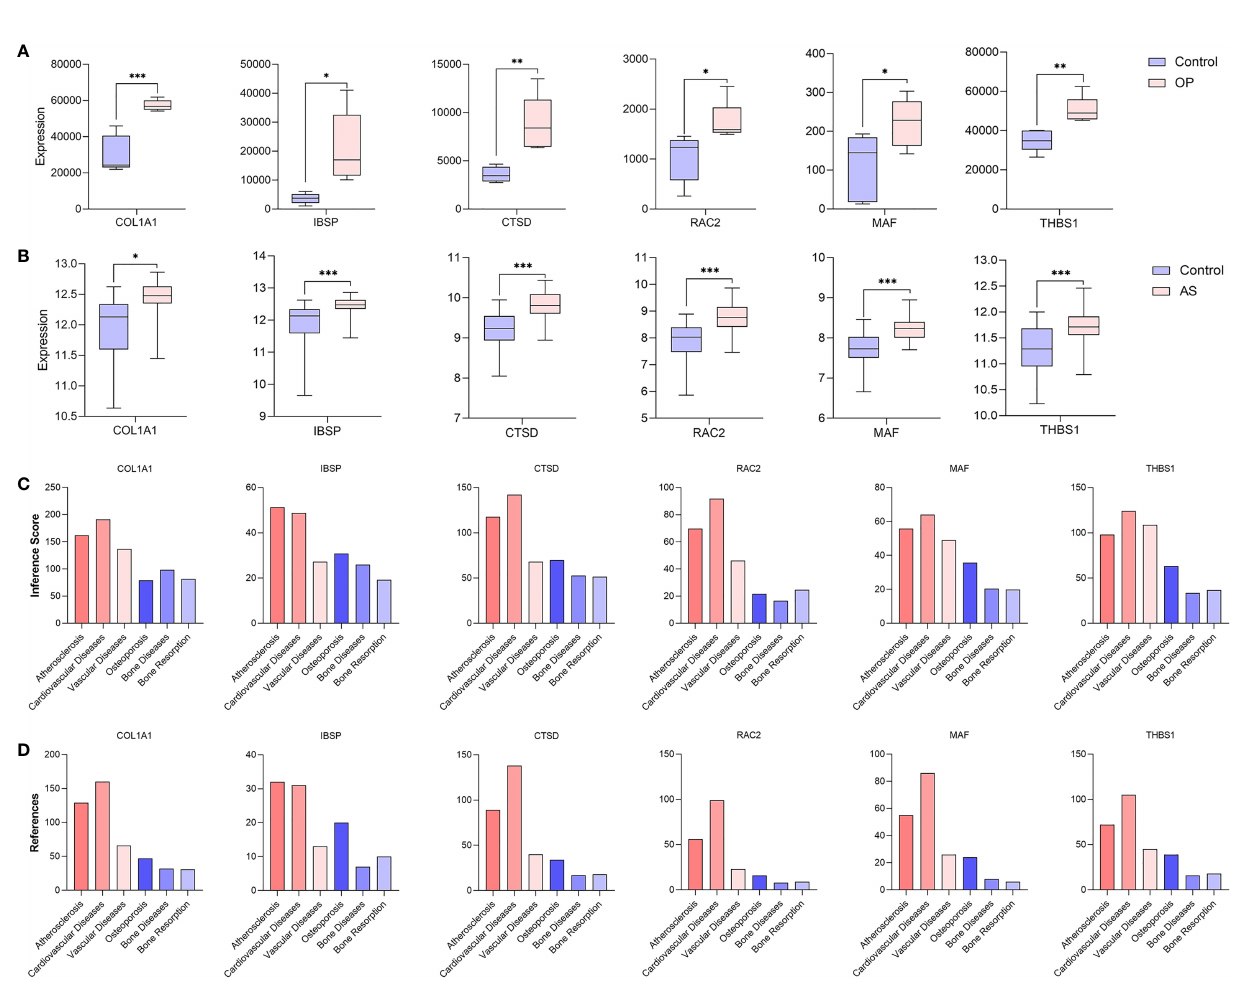
FIGURE 9 | Veri fi cation of hub genes. (A) The expression level of hub genes in GSE35956. (B) The expression level of hub genes in GSE43292. The comparison between the two sets of data uses the mean t-test; P -value < 0.05 was considered statistically signi fi cant. * p < 0.05; ** p < 0.01; *** p < 0.001. Inference score (C) and reference count (D) between hub genes and atherosclerosis, cardiovascular diseases, vascular diseases, osteoporosis, bone diseases, and bone resorption in CTD.